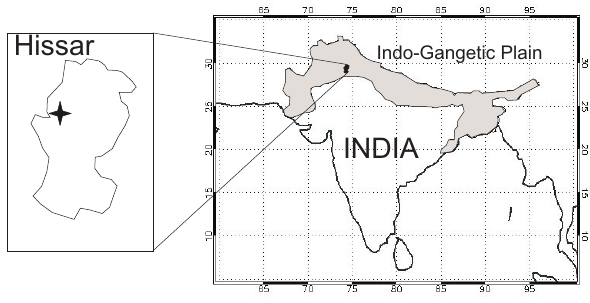
Fig. 1. Map showing the Indo-Gangetic Basin (IGB) and the obser- vation site at Hissar (29.13 ◦ N, 75.70 ◦